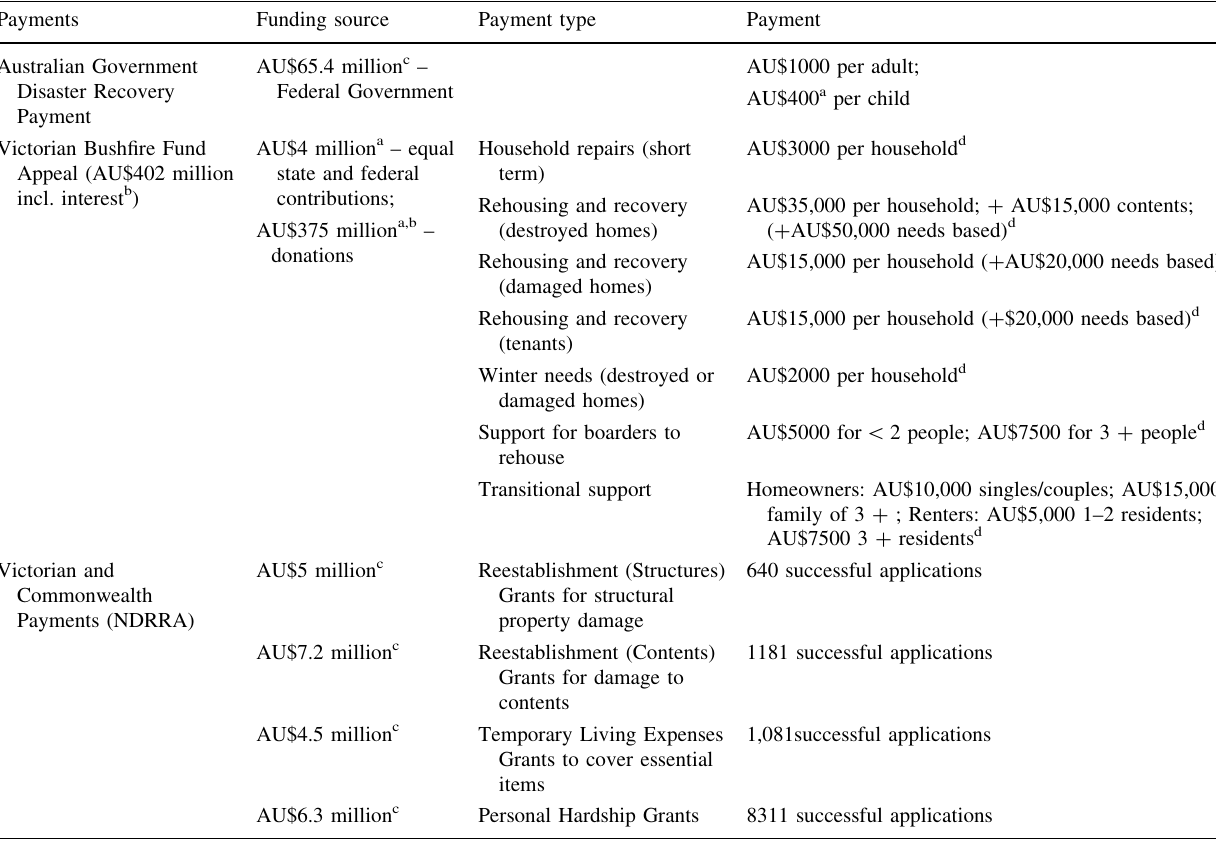
Table 2 Post-disaster impacted household funding, 2009 Black Saturday bushfires